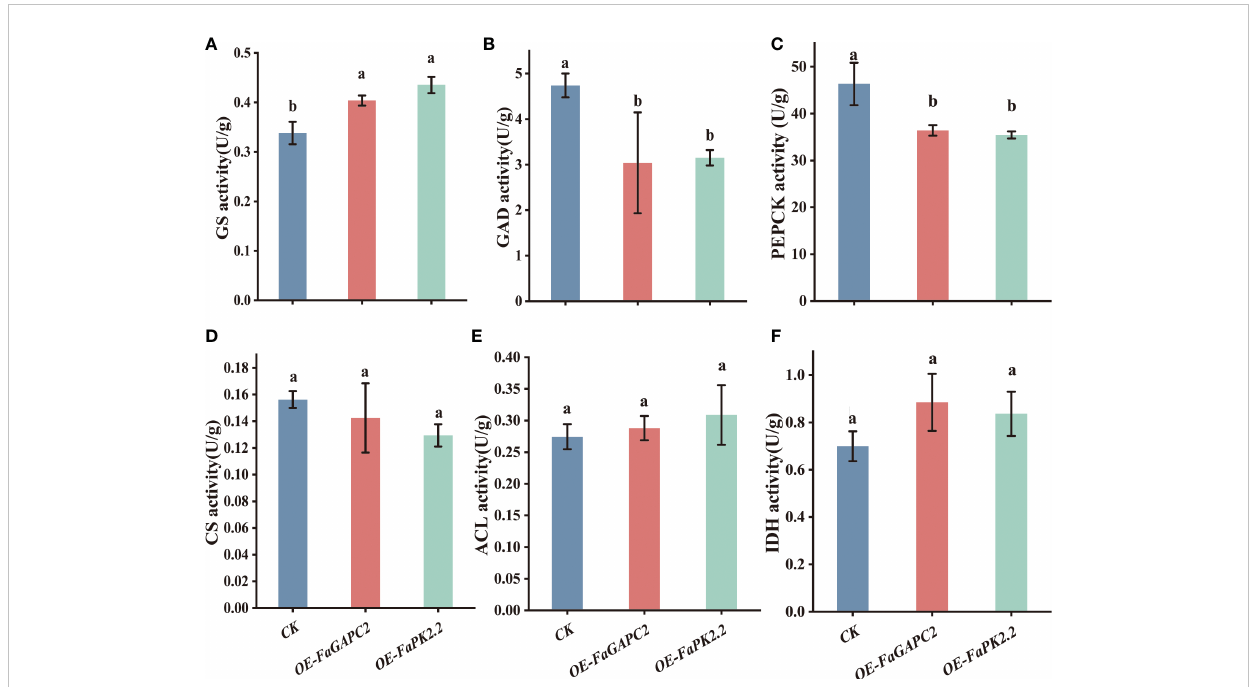
FIGURE 5 Enzymatic activity involved in the citric acid metabolism in FaGAPC2/FaPKc2.2- overexpressed fruit. GS activity (A) , GAD activity (B) , PEPCK activity (C) , CS activity (D) , ACL activity (E) , IDH activity (F) . GS, glutamine synthetase; GAD, glutamic acid decarboxylase; PEPCK, phosphoenolpyruvate carboxykinase; CS, citrate synthase; ACL, ATP-citrate lyase; IDH, isocitrate